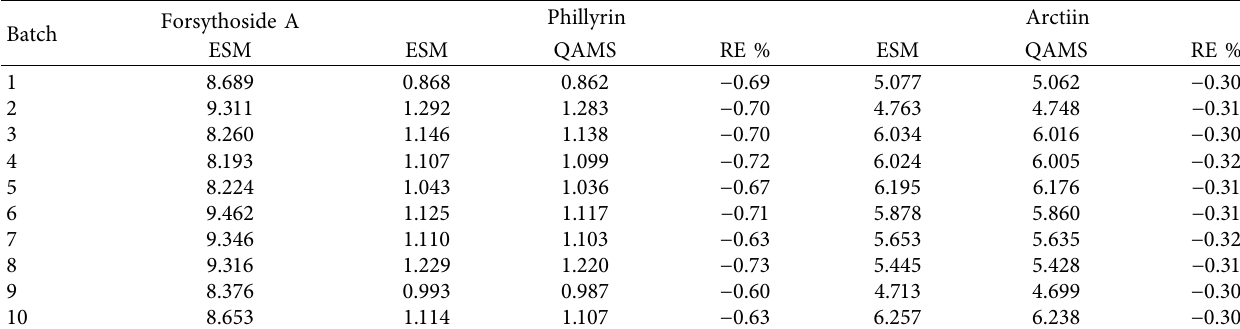
Table 8: Te calculation results of the ESM and QAMS method at 237nm.